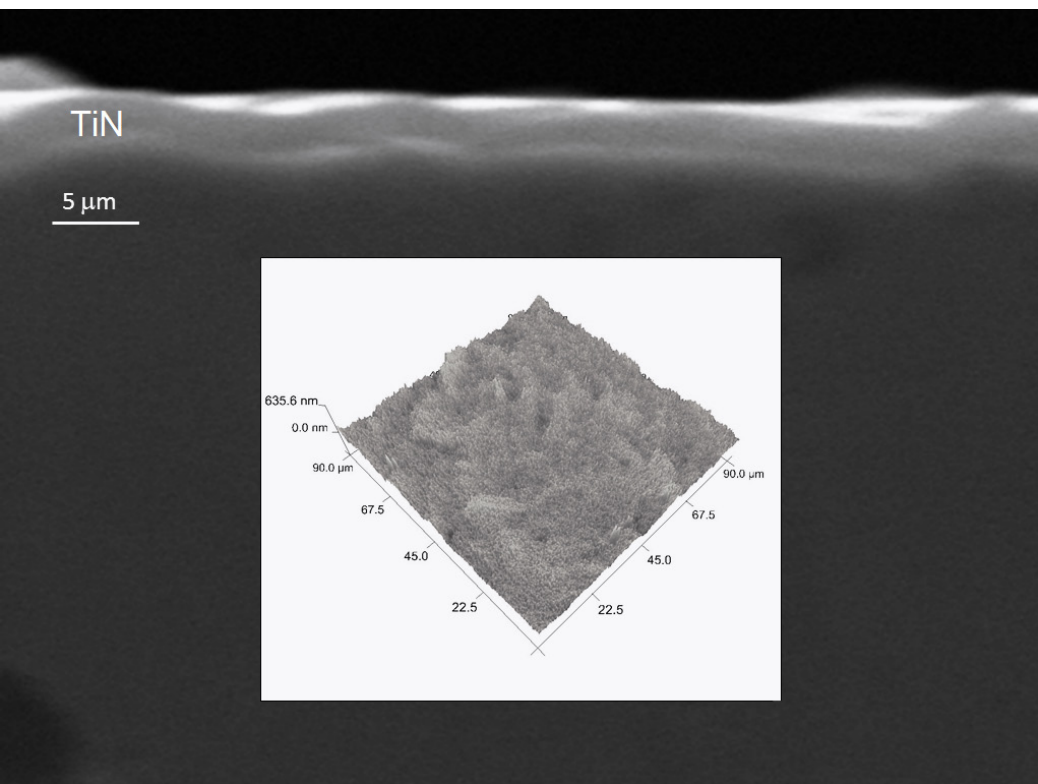
Figure 3. Cross-section view of the thickness of TiN coating by scanning electron microscopy and the morphology of the TiN coating by AFM